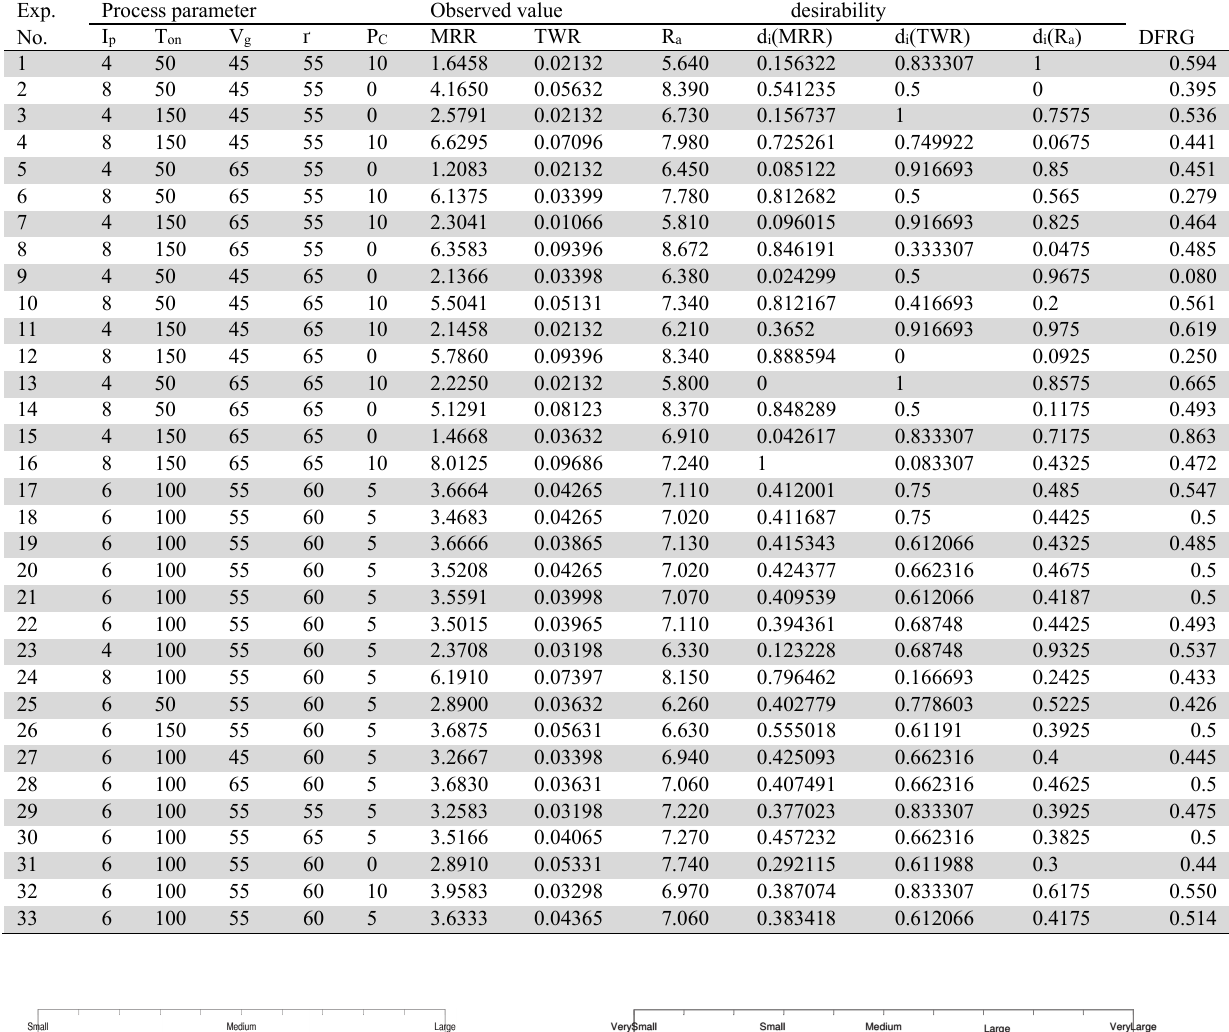
Experimental layout and DFRG value of PMEDM performance characteristics